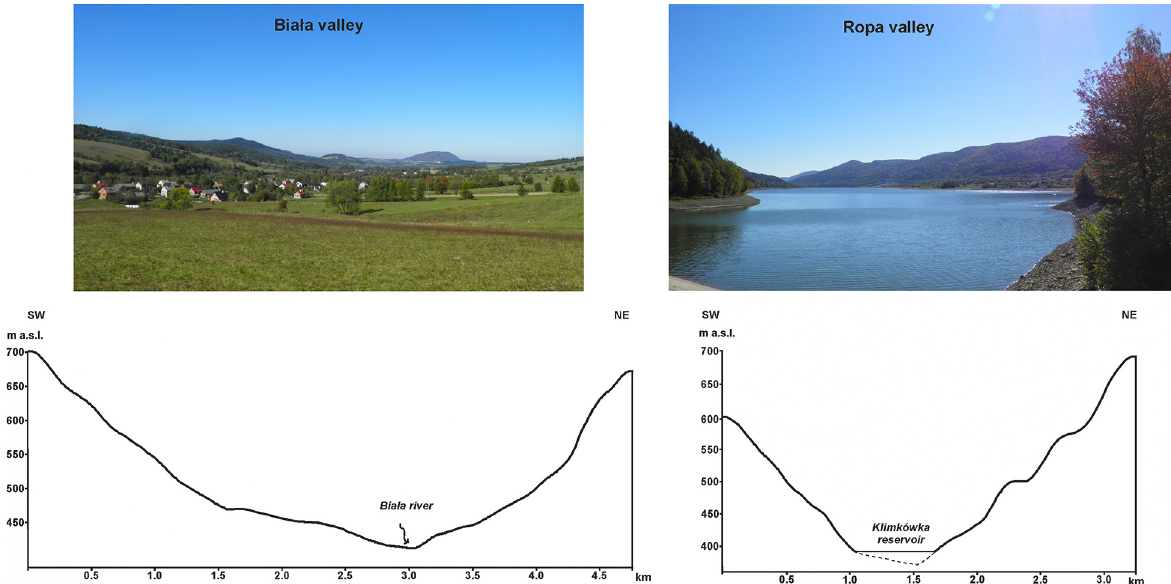
Fig. 2. Cross-sectional profile of the Biała and Ropa valleys (including the Klimkówka reservoir) in the tested areas.